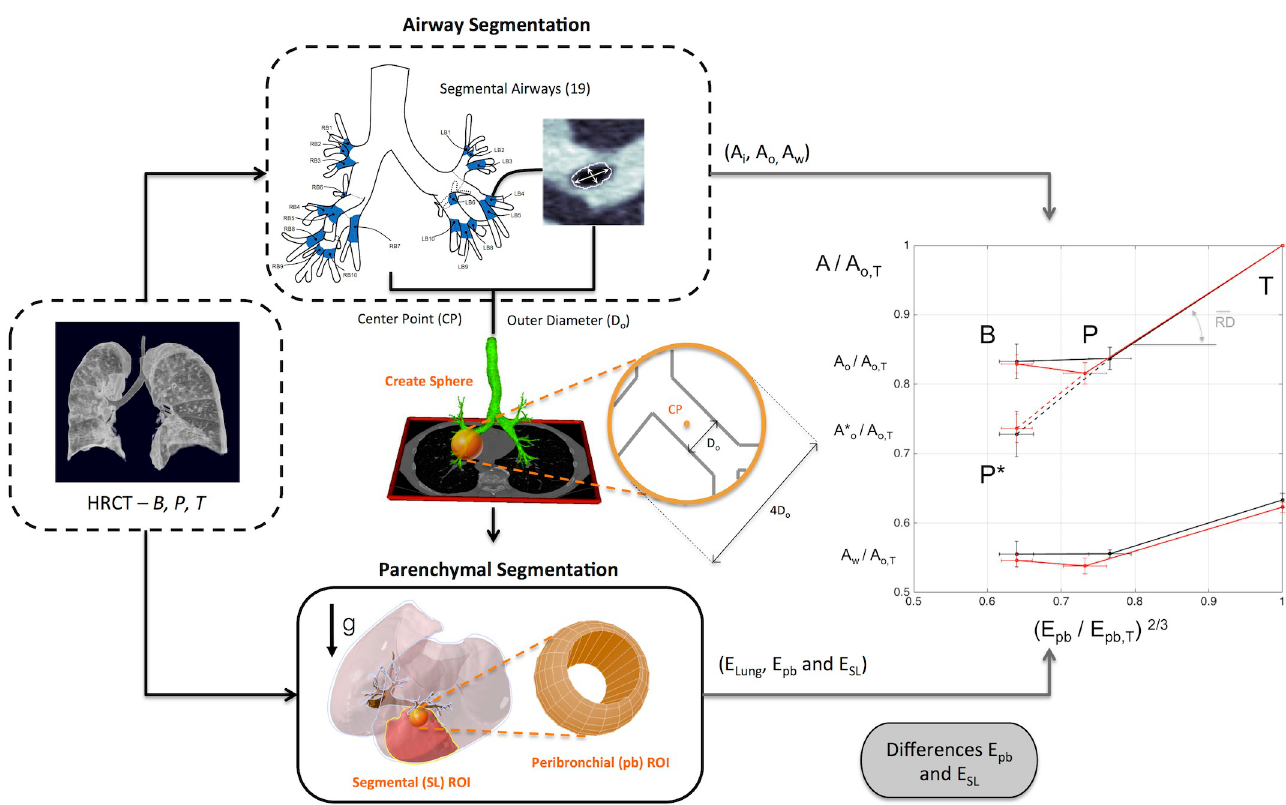
Fig 3. Methodology overview. Airway and parenchymal segmentation were performed to the HRCT images at the three different conditions. Using VIDA software, values of inner ( A i ), outer ( A o ) and wall ( A w ) cross-sectional areas were obtained for each of the 19 segmental airways. A spherical region of diameter four times the outer airway diameter was defined around each airway center point. Intersection of the sphere with the parenchymal mask defined a peribronchial (pb) ROI, and its average expansion ( E data shown in the plot are averages for all AS (black) and NA (red) subjects. (One graphical element on this Fig is a modified version from original in http://image.